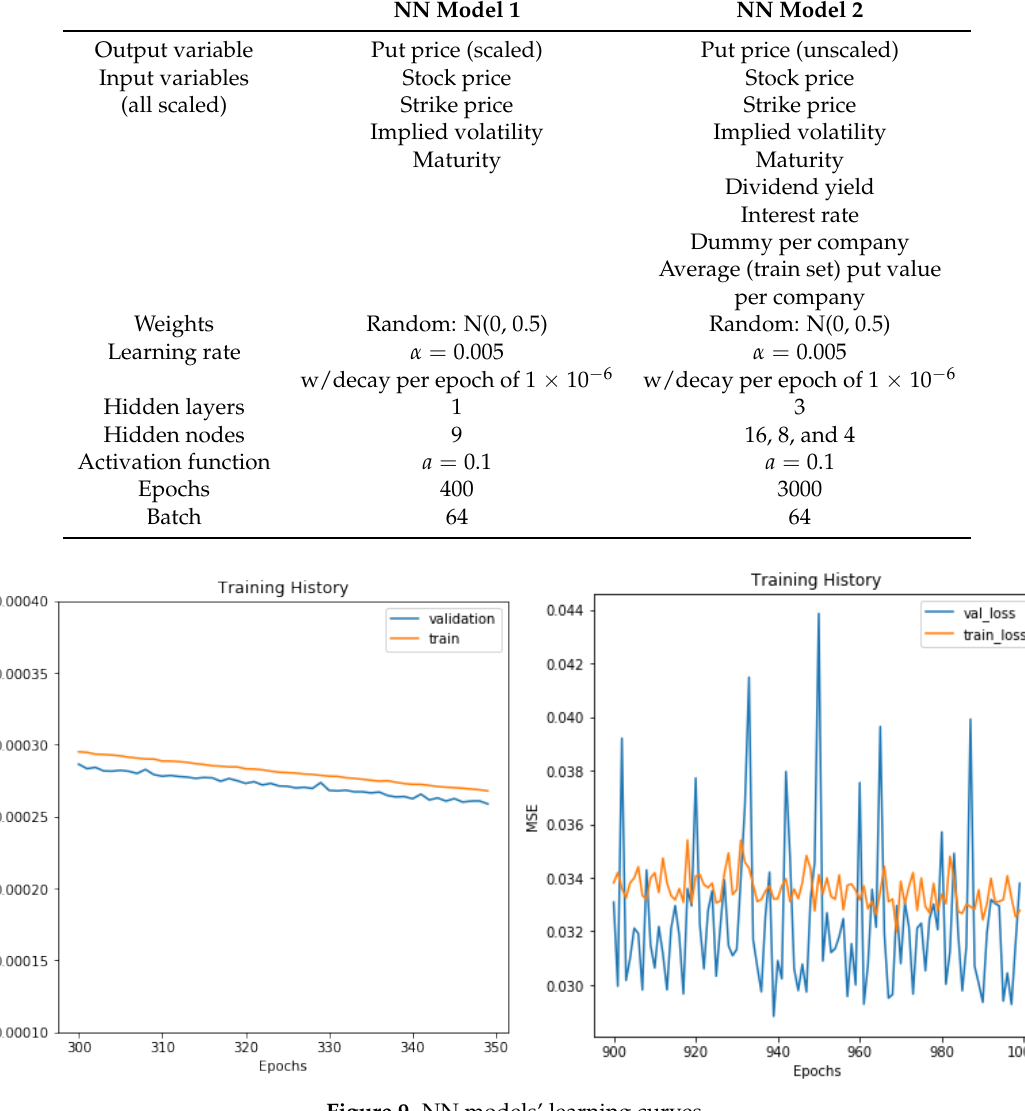
Table 5. NN models.